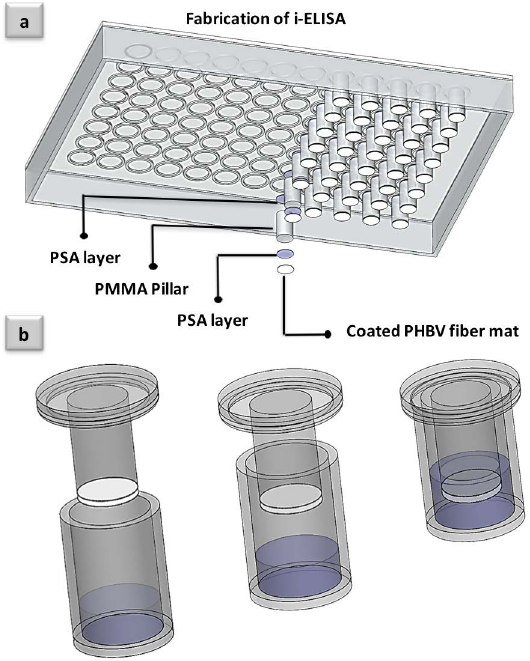
Figure 2. Fabrication of i-ELISA (intrant enzyme-linked immunosorbent assay) platforms: ( a ) modification of the lid of a 96-well plate; and ( b ) fixation of PHBV electrospun fiber mat and intrusion into ELISA liquid